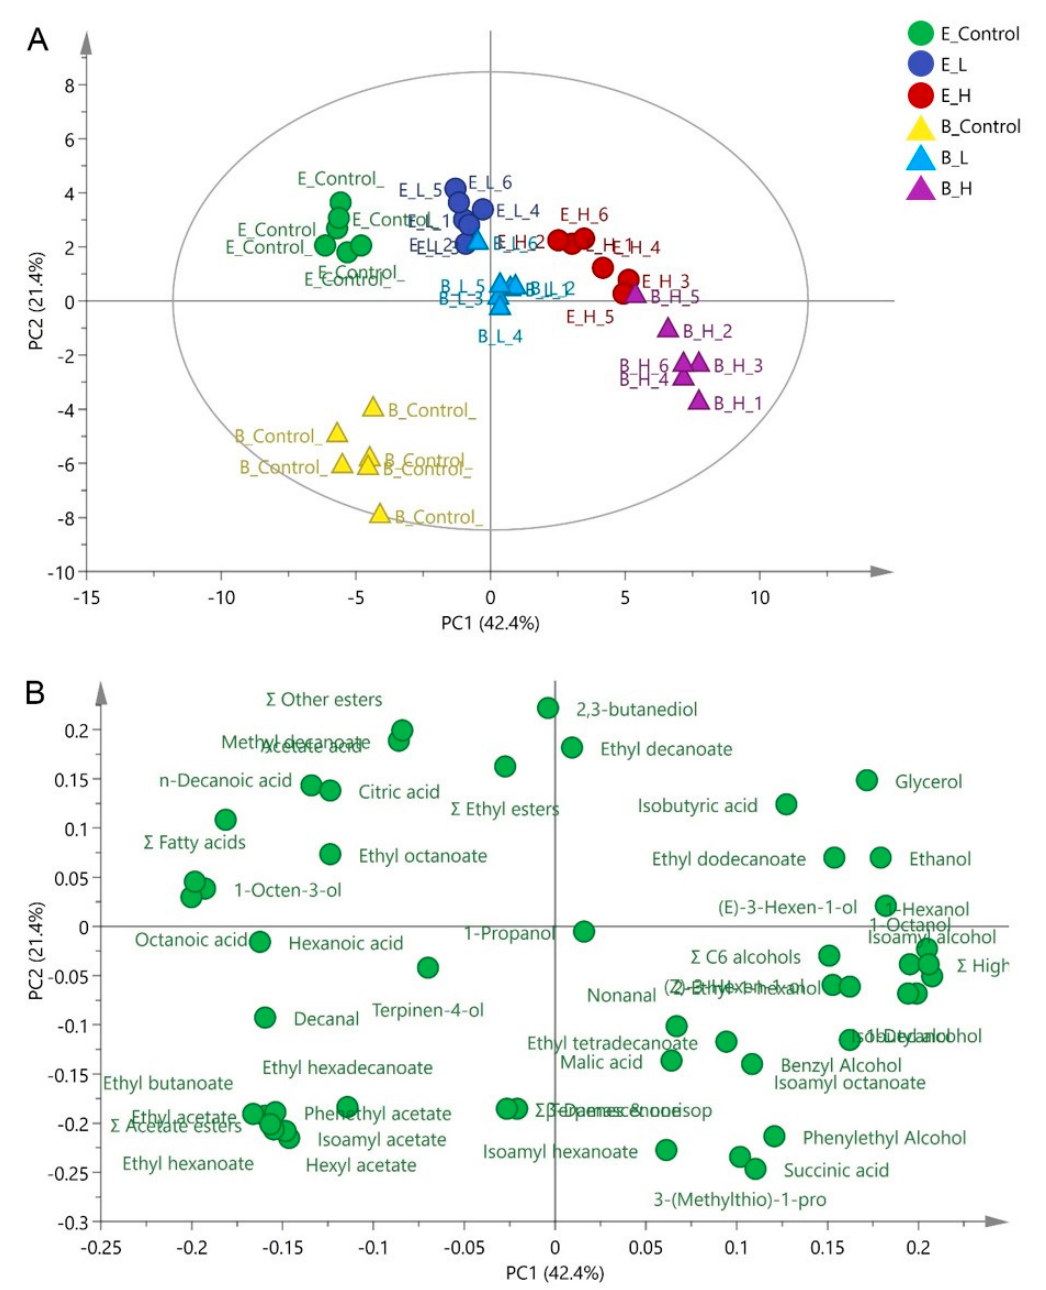
Figure 2. Principle components analysis using thirty-five volatile compounds and major fermentation products (including ethanol, glycerol, acetic acid, malic acid, citric acid, and succinic acid) in wines treated by different levels of UFAs (( A ) Scatter plot; ( B ) loading plot). E_Control, E_L, and E_H represented the control, low-UFAs, and high-UFAs added wines fermented by EC1118 strain, respectively; B_Control, B_L, and B_H represented the control, low-UFAs, and high-UFAs added wines fermented by BDX strain,